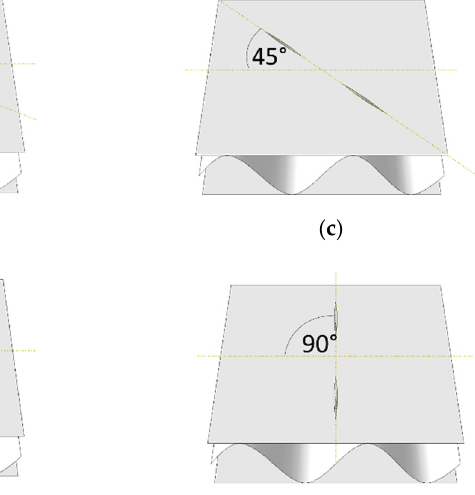
Table 2. Sample symbols.